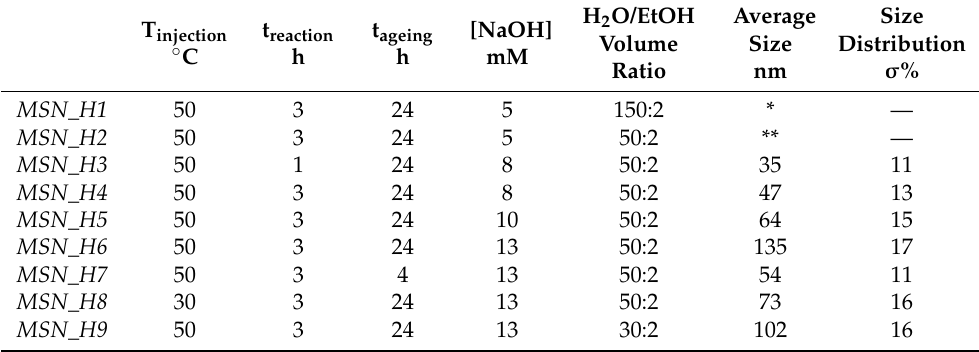
Figure 1. ( A ) Sketch of the synthetic MSNs in homogeneous solution. Step 1: (i) EtOH and TEOS are added to CTAB micellar aqueous solution at alkaline pH by NaOH at injection temperature, T injection , the reaction mixture is let stirring for different reaction time (t reaction ) then (ii) the temperature is decreased at room temperature (t ageing ) to allow MSNs growth. Step 2: surfactant template removal; ( B – E ) TEM micrographs (scale bar 50 nm) of MSNs (see also Table 1) MSN_H3 ( B ), MSN_H4 ( C ), MSN_H5 ( D ) and MSN_H6 ( E ); ( F ) Scatter plot of MSN average size, including size distribution as function of NaOH concentration and t reaction ; ( G ) FTIR spectra recorded in ATR mode in the 1300–880 cm − 1 range of MSNs samples (panel ( F )). Table 1. Reaction conditions used for the MSNs synthesis following the homogenous solution approach and average size and size distribution of the obtained samples, determined by TEM characterization. (*) and (**) correspond to amorphous structures and barely defined spherical particles, respectively (see Figure S1 in the Supplementary